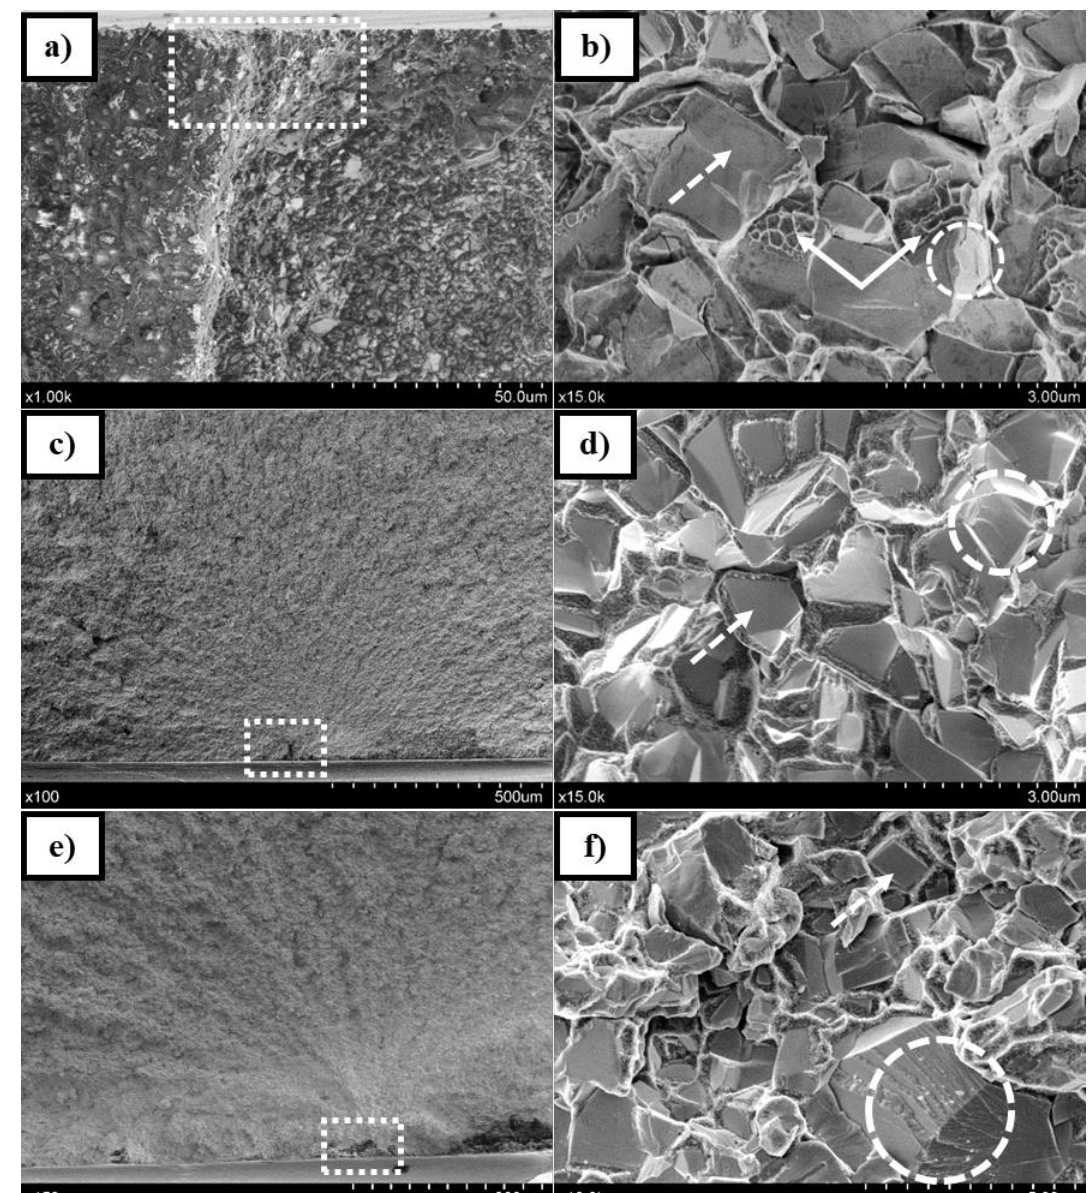
Figure 5. Representative SEM micrographs of the fracture surfaces showing the fracture origin (dotted squares) and the unstable fracture region, where the micromechanisms associated to the fracture are shown: dimples (straight arrows), cleavage (dotted arrows), and river patterns (dotted circles). ( a , b ) The 27C grade at room temperature, ( c , d ) the 16M grade at 600 °C, and ( e , f ) the 27C grade at 600 °C.